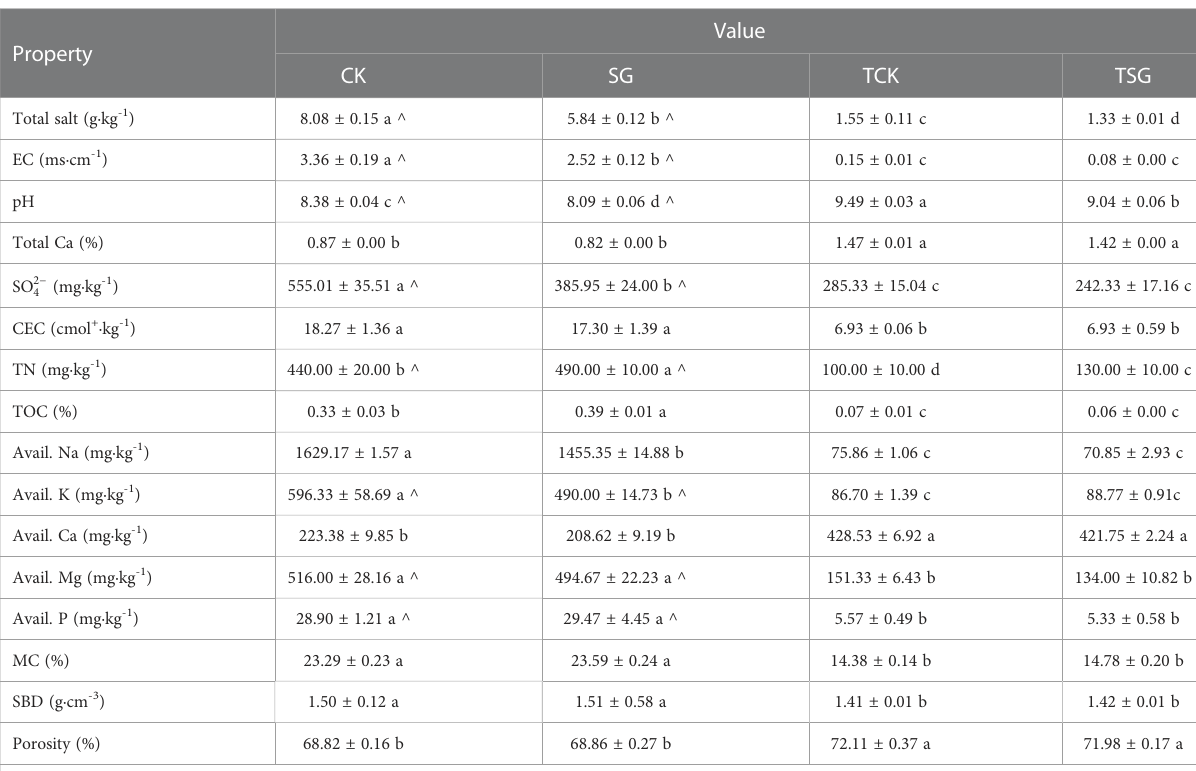
TABLE 1 Physico-chemical properties of soil.